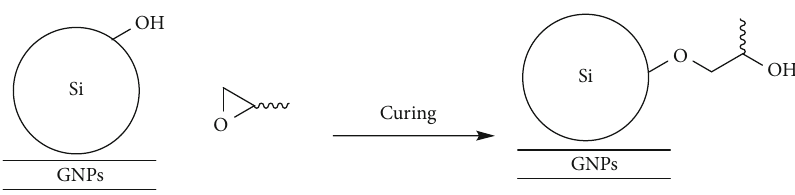
Figure 5: Linkage representation of epoxy resin to the hybrid